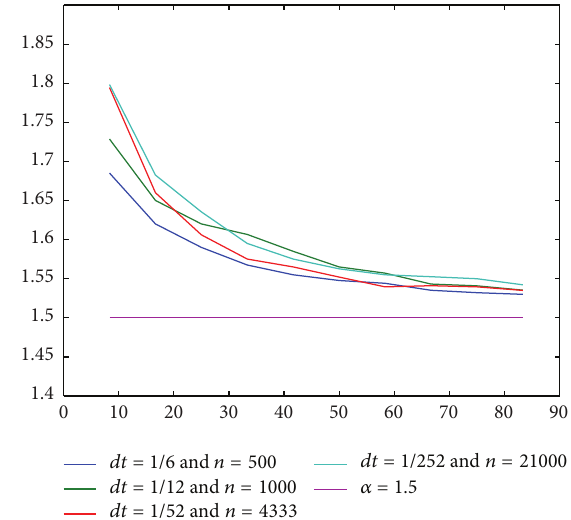
Figure 1: 𝛼 estimation results. 𝑑𝑡 = 1/6, 1/12, 1/52, and 1/252, 𝑛 = 500, 1000, 4333, and 21000, respectively.